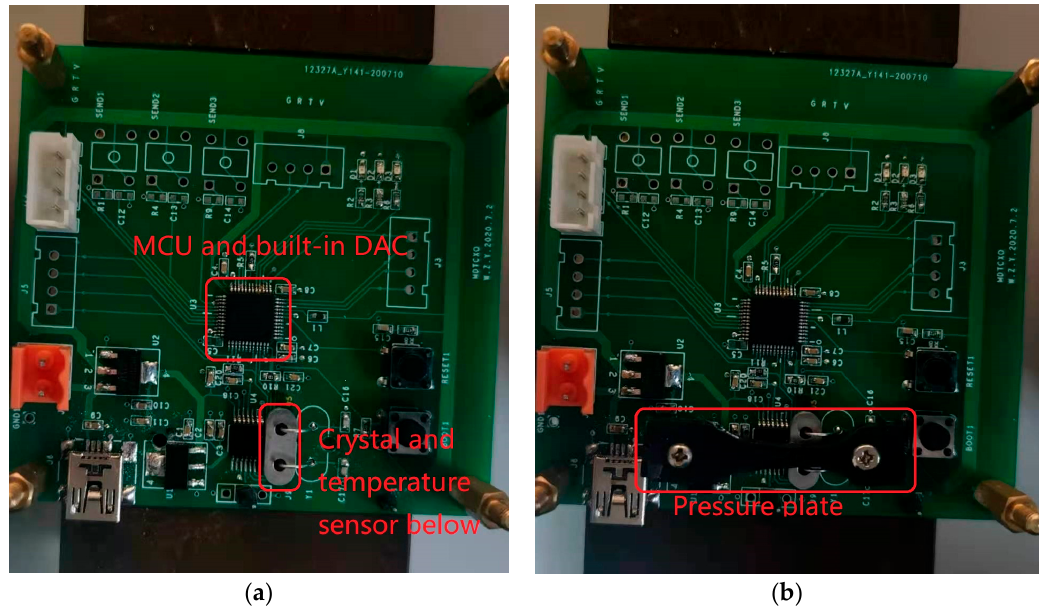
Figure 4. ( a ) TCXO physical diagram before installing the pressure plate; ( b ) TCXO physical diagram after installing the pressure plate.